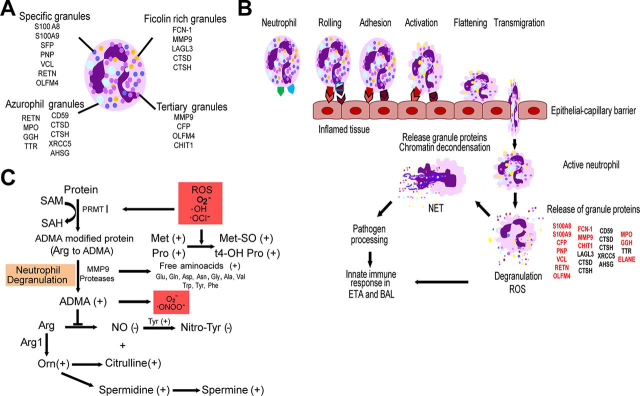
Proposed mechanisms of neutrophil-mediated innate immune responses in the respiratory tract upon VAP infection.A, Neutrophil granules and their proteins detected in ETA and BAL. B, Recruitment of neutrophils at the site of inflamed trachea and alveoli in response to pathogen stimuli. Neutrophil rolling, adhesion and transmigration into inflamed alveoli and tracheal tissues are facilitated by VCL, ACTN1, MYYH9, and MYH12. Activation of neutrophils can induce degranulation and release granule proteases, oxidases, peroxidases and other antimicrobial proteins for pathogen processing (53). C, Proposed metabolic fate of neutrophil degranulation and reactive oxygen species (ROS)-induced oxidative stress in the respiratory tract during VAP infection.